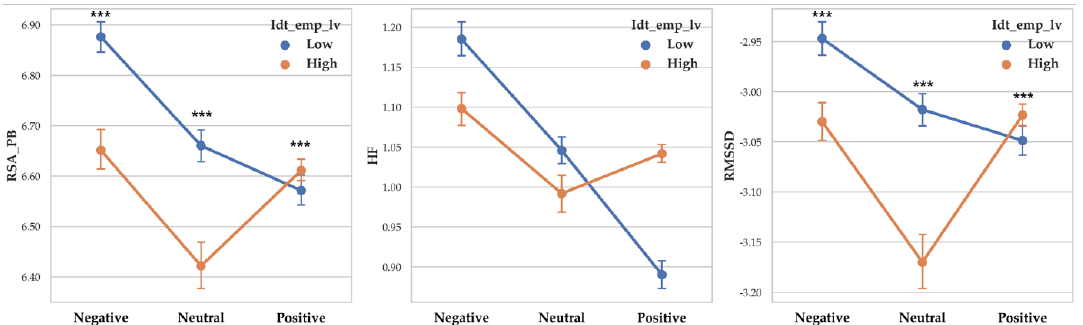
Figure 8. Point graph of vagal responses depending on identification empathy level when participant empathized with each valence level. Idt_emp_lv refers to identification empathy level. Point means mean of vagal responses. Asterisk means significant vagal responses di ff erence according to identification empathy level. (***: p <